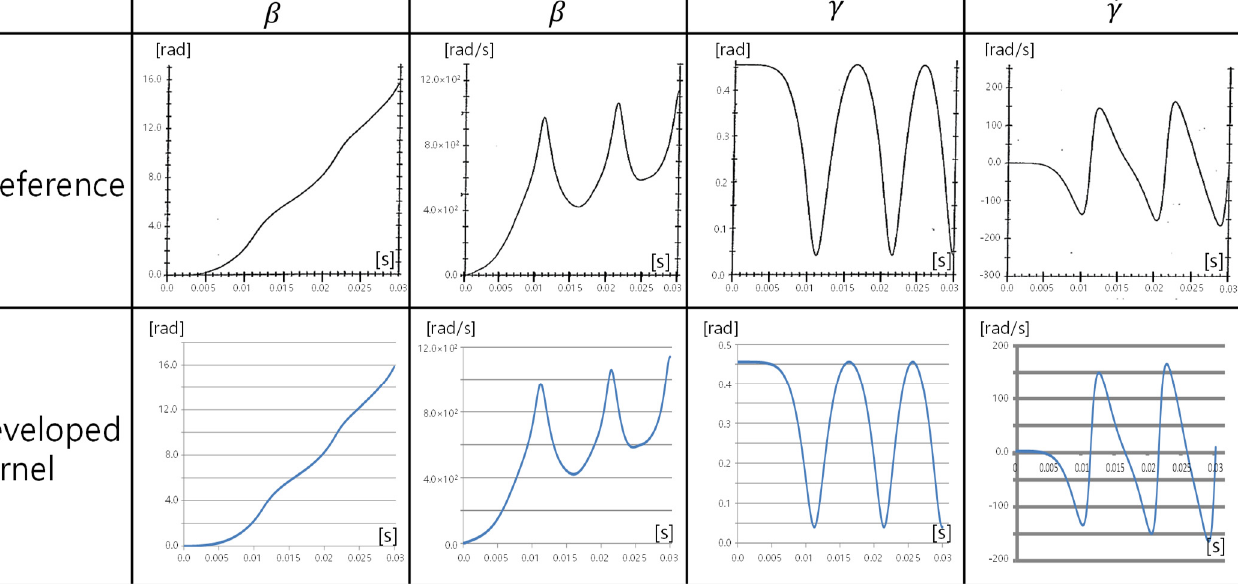
Figure 8. Simulation results of the position and velocity of the generalized coordinates β and γ compared with those obtained from reference.